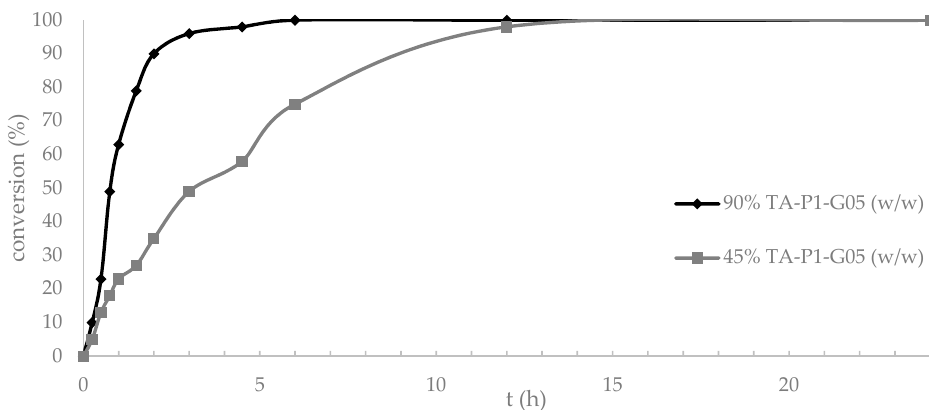
Figure 3. Study of the enzymatic transamination of ketone 6 with TA-P1-G05 over time employing: ( ) 90% of enzyme loading ( w / w ) or ( ) 45% of enzyme loading ( w / w vs. 6 ).